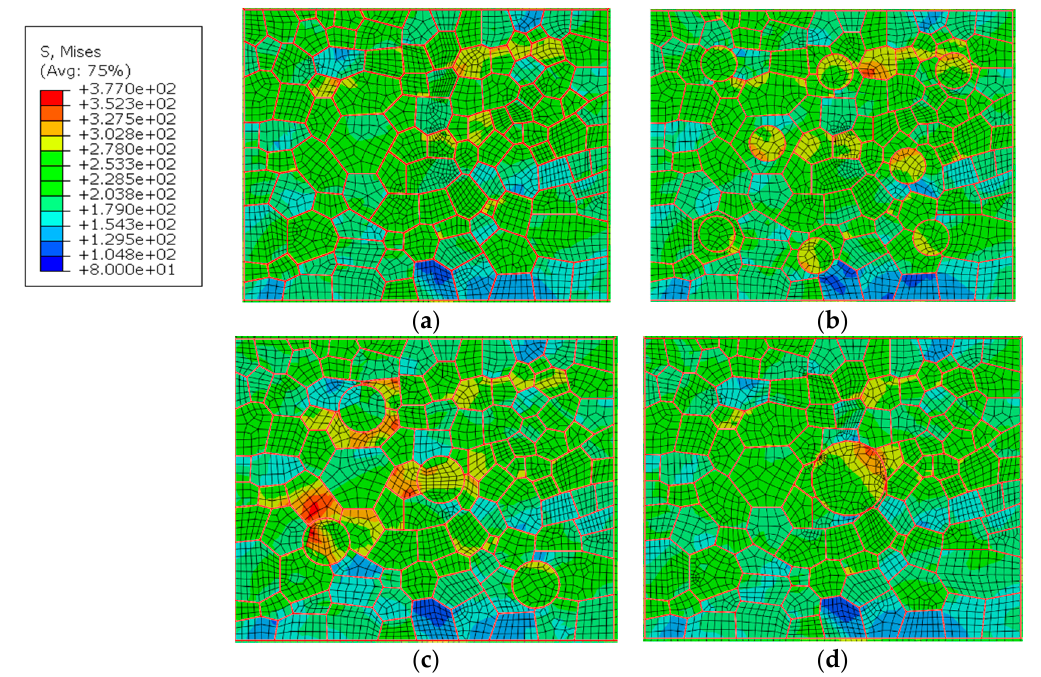
Figure 16. Stress distribution ( a ) without particle, and with ( b ) 5 μ m *8, ( c ) 6.3 μ m *4, and ( d ) 10 μ m *1 particles, MPa.